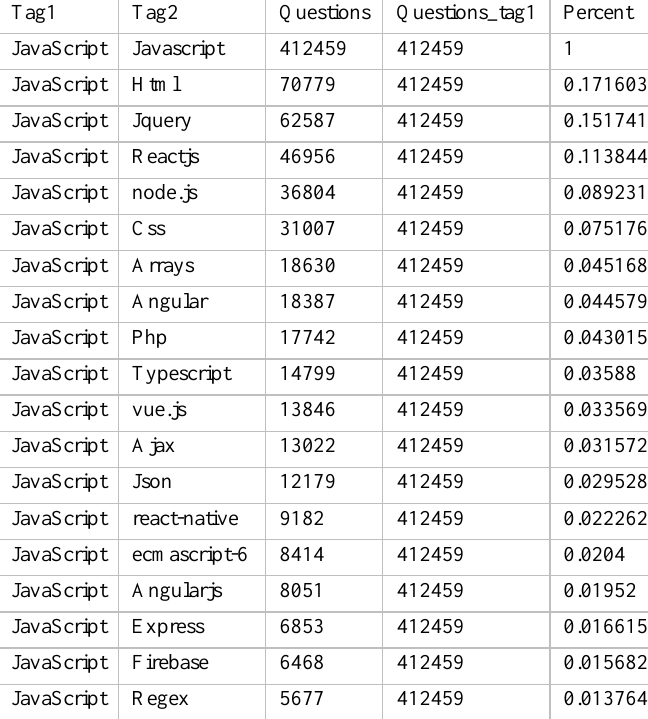
Table 5. 'JavaScript' tag occurrences with other